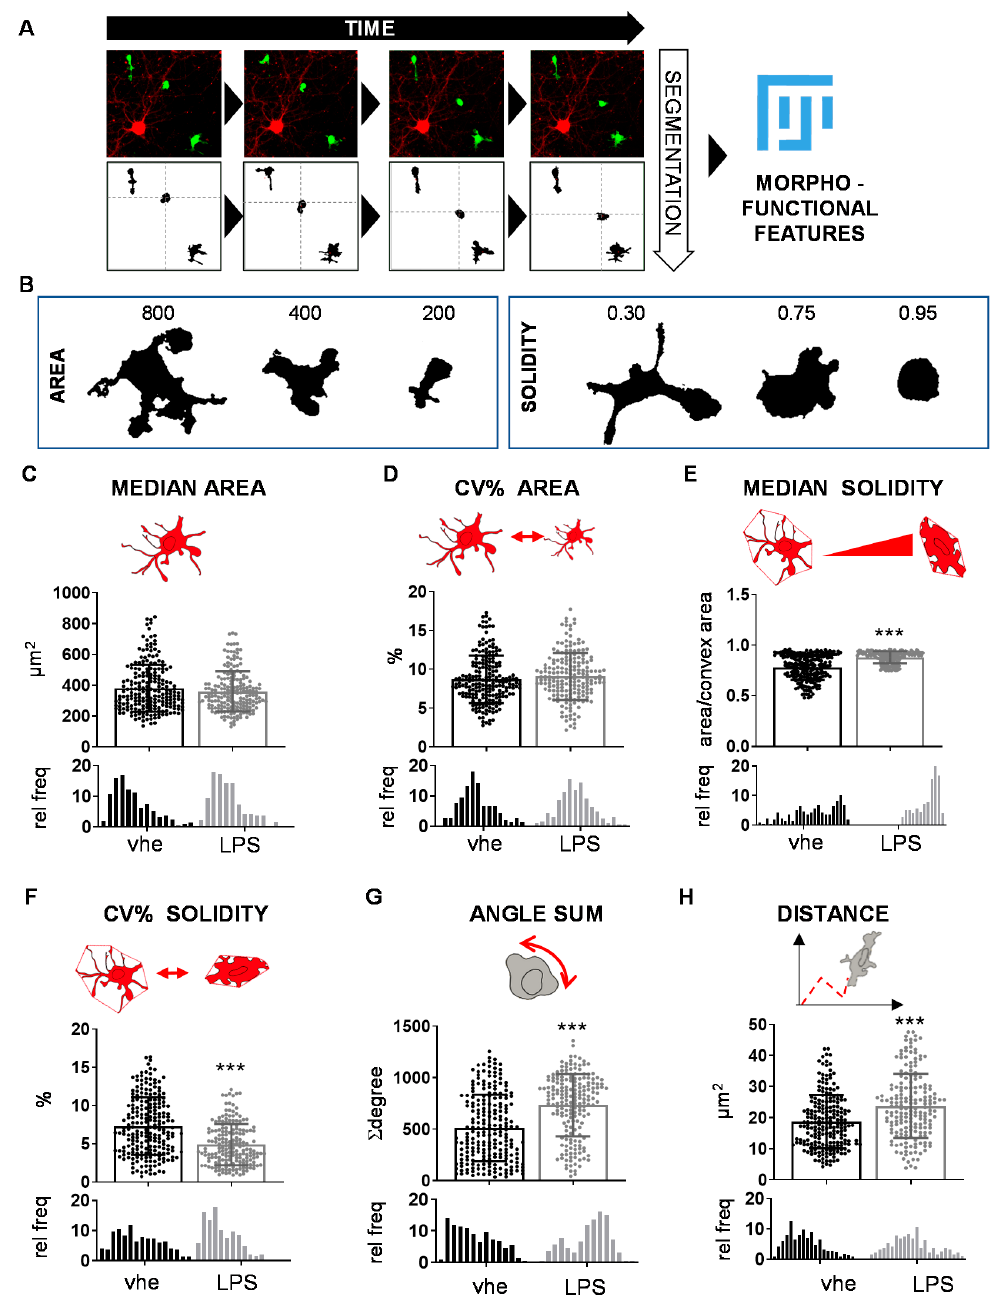
Figure 1. Unbiased morpho-metric method to detect morpho-functional changes. ( A ) Schematic representation of the image-based method for the morpho-functional clustering: GFP-marked microglia dynamics were recorded by time-lapse microscopy, and the acquired images were segmented and processed with Fiji software to obtain shape and dynamic descriptors for each microglial cell during the time lapse period. ( B ) Representative images of shape descriptors (area and solidity) used for the analysis. ( C–H ) Quantitative single-parameter analysis of lipopolysaccharide (LPS)-treated male microglia; the analysis includes ( C ) median area, ( D ) coefficient of variation (CV%) of the area, ( E ) median solidity, ( F ) CV% of solidity, ( G ) rotation, and ( H ) distance covered. The values are presented as mean ± SD (top) and as frequency distribution (bottom) of n = 3 independent experiments. The drawings are a schematic representation of the parameter reported in the graph. *** p < 0.001 calculated by t -test versus vehicle.